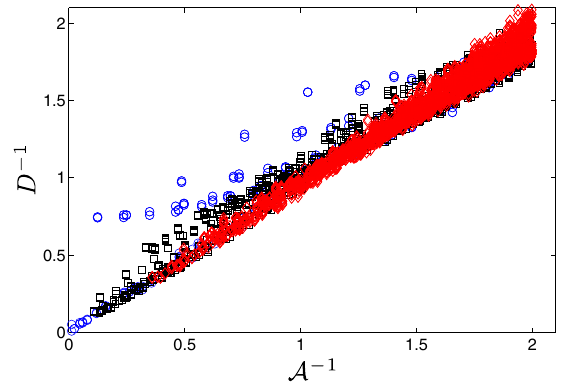
FIG. 24. Comparison between the inverse of the full dynamical functional approximant from Eq. (6), A − 1 , and the inverse of the nematic correlator D − 1 . Data shown represent L ¼ 16 , 20, and 24, h ¼ 3 . 525 , 3.7, 3.9, and 4.1, and temperatures T ¼ 1 . 0 , 0.67, 0.5, 0.33, 0.25, 0.17, 0.13, 0.1, 0.05, and 0.025. To exhibit the momentum dependence, we use blue circles for q ¼ 0 (403 data points), black squares for j q j ¼ ð 2 π =L Þ and ð 2 π =L Þ data points), and red diamonds for all other q (5,332 data points).